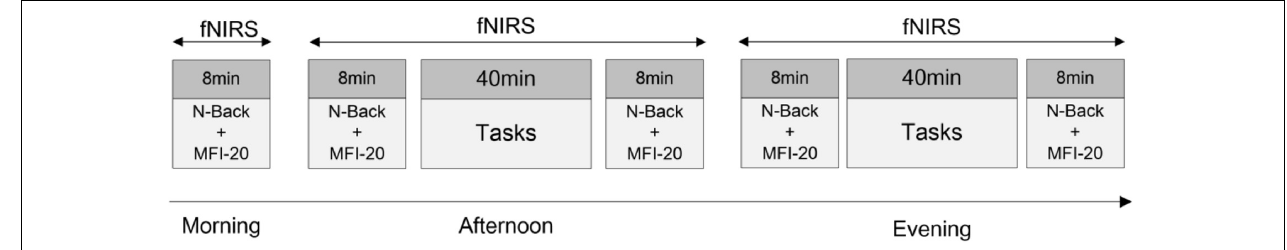
FIGURE 1 | Experimental procedure. About 8 min/person in the morning. The afternoon experiment and evening experiment are about 1 h/person.